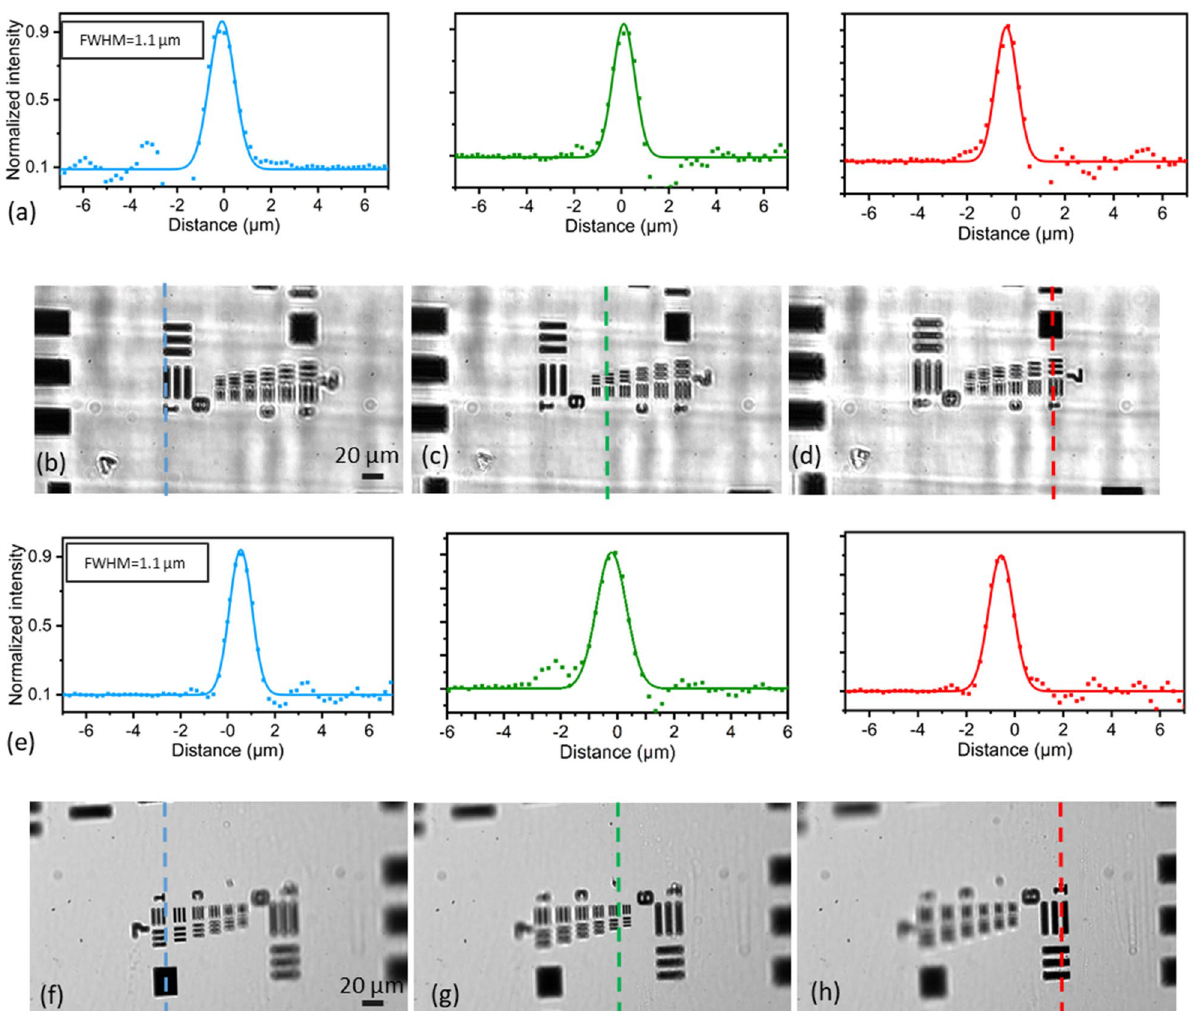
Figure 4. Imaging path characterisation with and without 3D-printed prism. ( a ) Experimental PSFs derived from the Edge Spread Function for all three focal plane positions including the 3D-printed prism, showing a resolution limit of 1.1 μm FWHM. ( b )–( d ) Cropped image of 30° USAF 1951 target group 7 for three different inputs of the tunable lens. Dotted vertical lines indicate where the focal point of the image is centred. ( b ) z = − 50 μm with V tunable = − 60 mV, ( c ) z = 0 μm with V tunable = 0 V, ( d ) z = 50 μm with Vtunable = 60 mV. ( e ) Experimental PSFs derived from the Edge Spread Function for all three focal plane positions without the 3D-printed prism, showing an identical resolution limit. ( f )–( h ) Cropped image of 30° USAF 1951 target group 7 for the same three different inputs of the tunable